Question: Judging by this figure, is the value going up or going down?
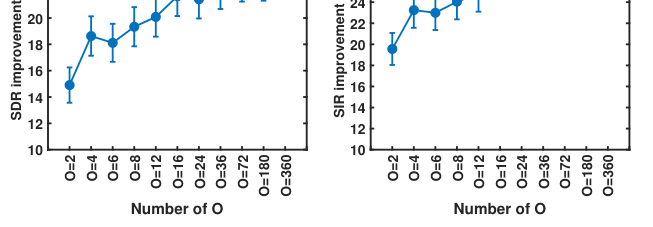
Answer: increasing